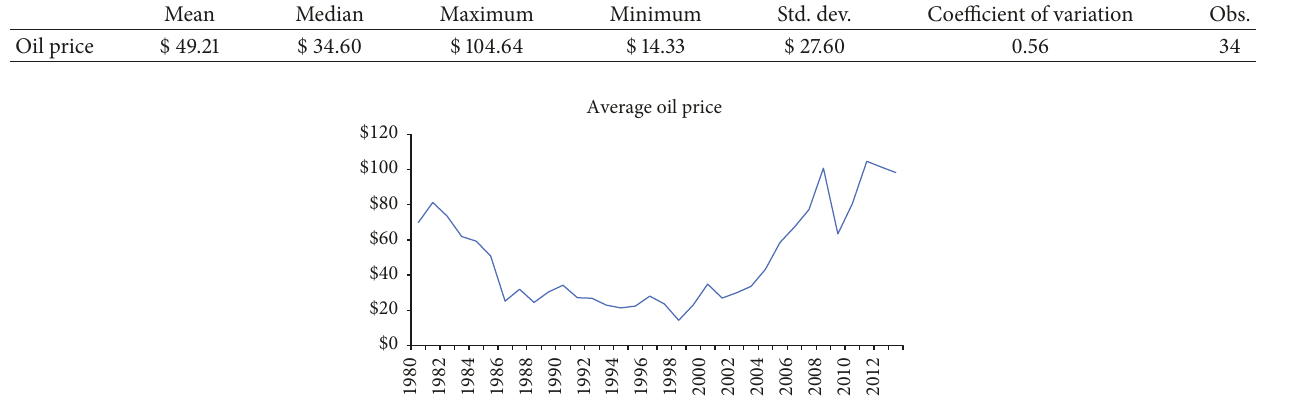
Figure 3: Average annual oil price in US dollars per barrel, deflated to 2013 dollars. Source : EIA, 2014 [45].